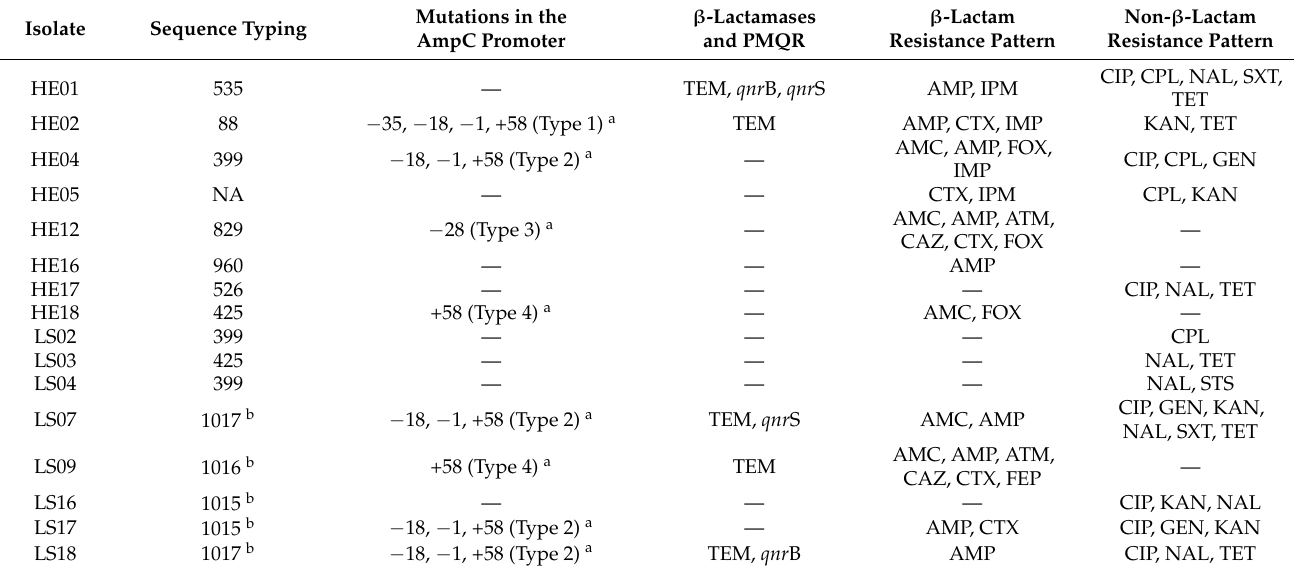
Table 3. Resistance genes identified in the E. coli strains that demonstrated β -lactam and quinolone